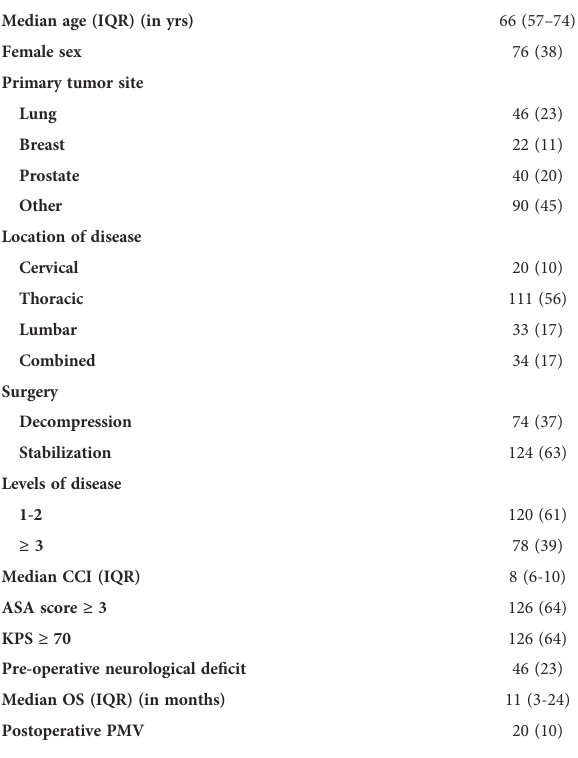
TABLE 1 Patient